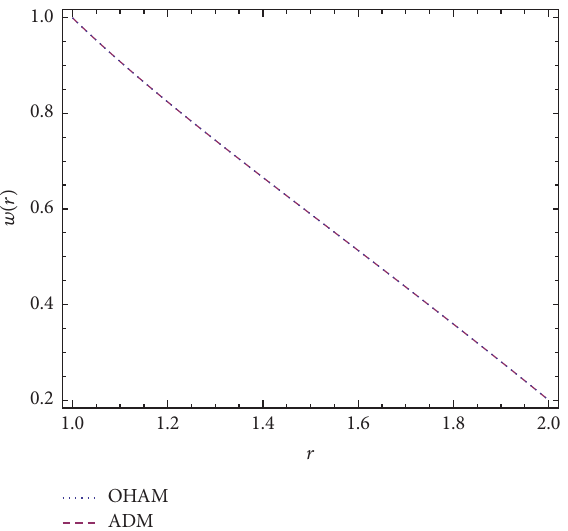
Figure 5: Velocity comparison between OHAM and ADM results when 𝑈 = 0.2 , 𝛽 1 = 0.1 , 𝛽 2 = 0.5 , 𝜆 = 0.3 , 𝐶 1 = −0.001243429 , = −0.000248121 , 𝐶 = 0.001032981 , and 𝐶 = 0.000294127 . 𝐶 2 3 4